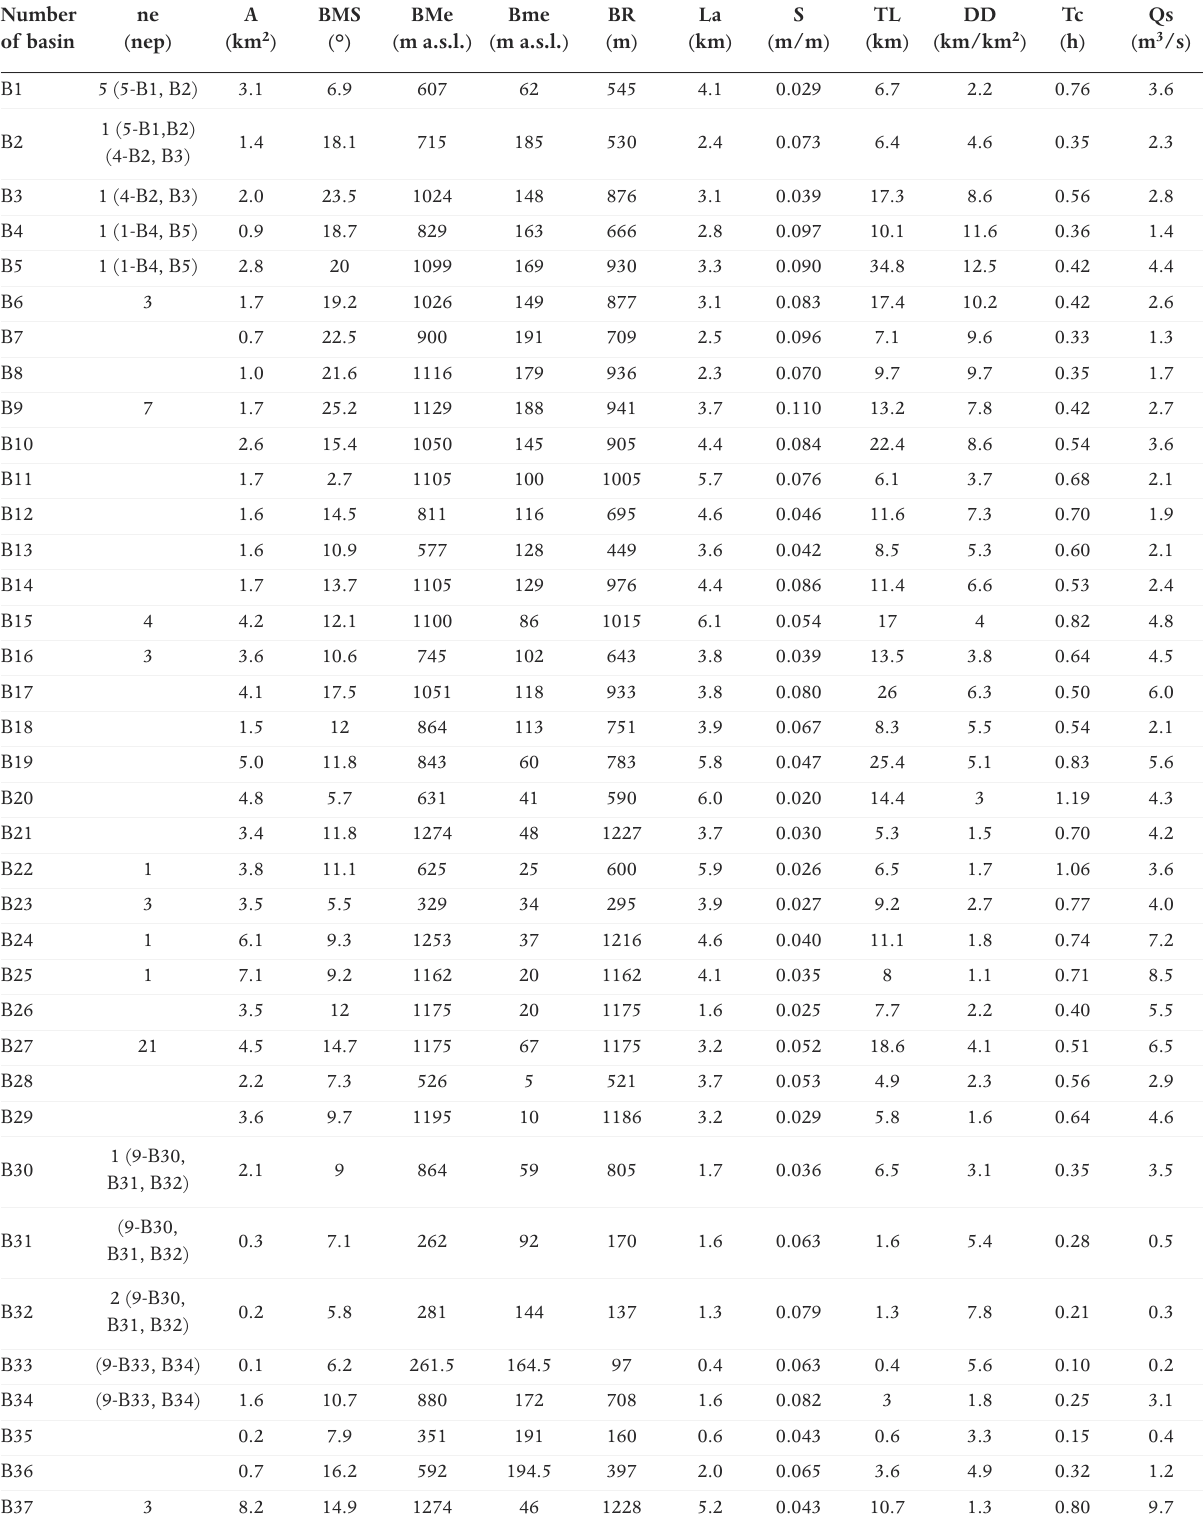
Table 1. Geomorphological and run-off data for the Somma-Vesuvius basins: number of flood events for single (ne) and multiple, cumula- tive basins (nep); A (drainage basin area); BMS (Basin Mean Slope); BMe (Basin Maximum elevation); Bme (Basin minimum elevation); BR (Basin relief = BMe minus Bme); La (length of the main stream); S (average slope of the master stream); TL (Total stream length); DD (drainage density); Tc (time of concentration); Qs (Specific discharge